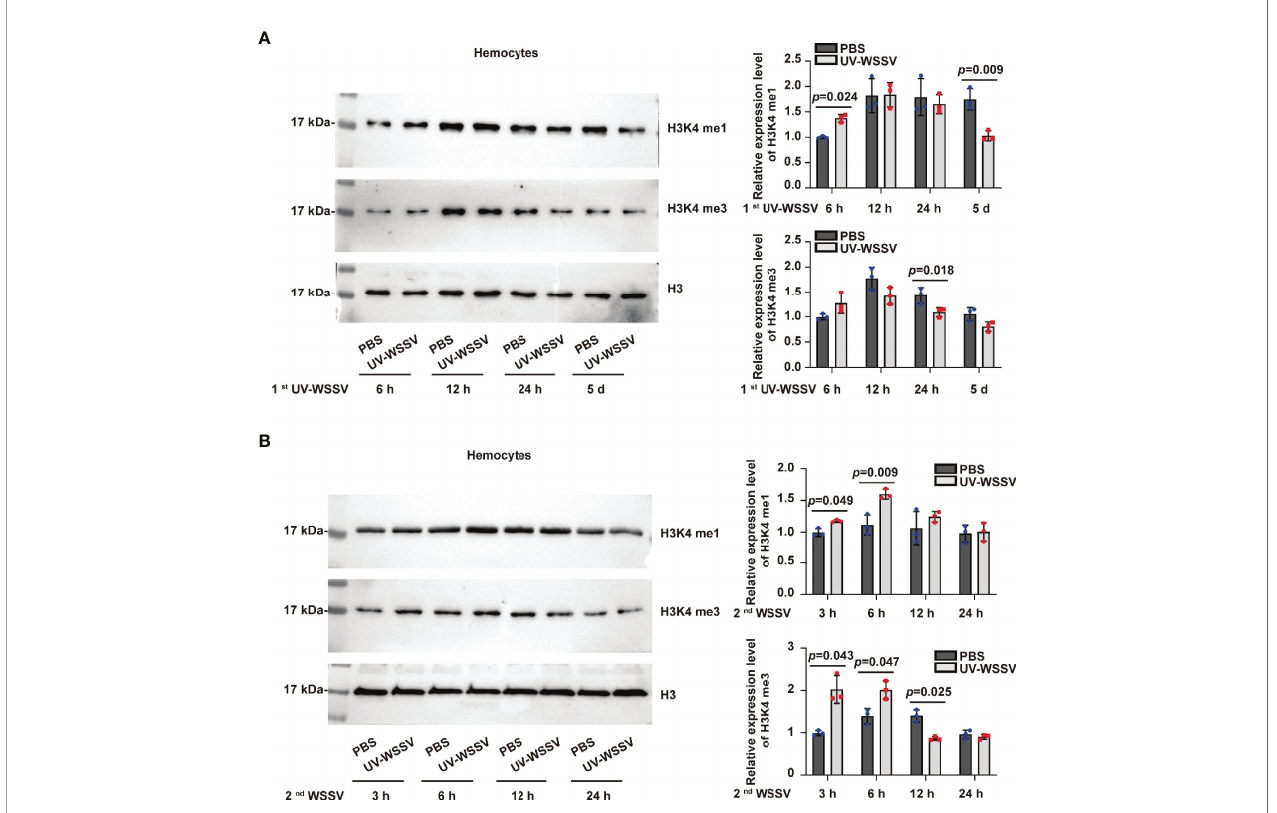
FIGURE 8 | H3K4me1 and H3K4me3 were involved in trained immunity in shrimp. Histones were extracted from PBS and UV-WSSV trained shrimp at different time points, and H3K4me1 and H3K4me3 were analyzed using western blotting. (A) H3K4me1 modi fi cation analyzed by western blotting using anti-H3K4me1 as the primary antibody and statistical analysis based on three experiments. (B) H3K4me3 modi fi cation analysis using anti-H3K4me3 as the primary antibody and statistical analysis based on three experiments. The bands of western blotting were digitalized using Image J software, and the differences between trained and control groups at different time points was analyzed by student ’ s t test, p < 0.05 was accepted as signi fi cant